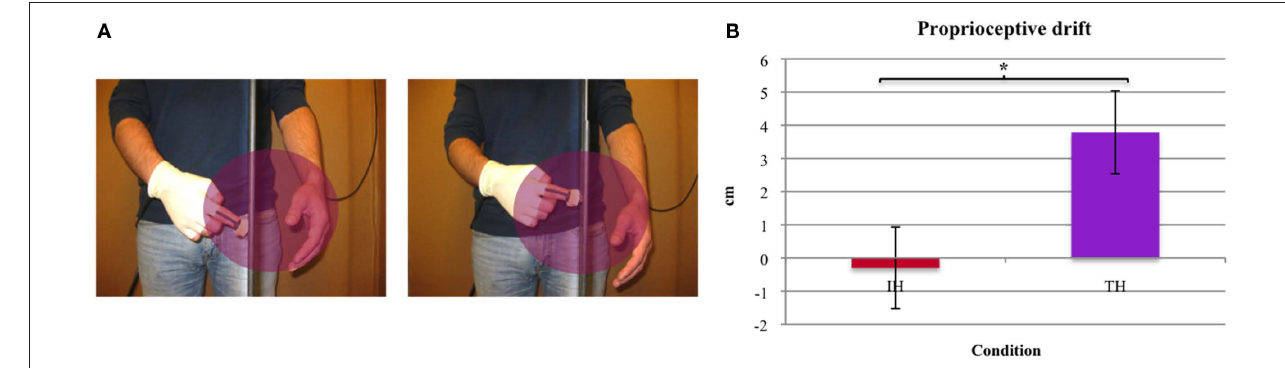
position in space during the experiment. Cameras were occluded during each pointing movement to exclude reliance on visual information. (B) Proprioceptive drift for the IH and TH condition as measured by the difference in pointing before vs. after the induction of the illusion (paired samples t -test – p